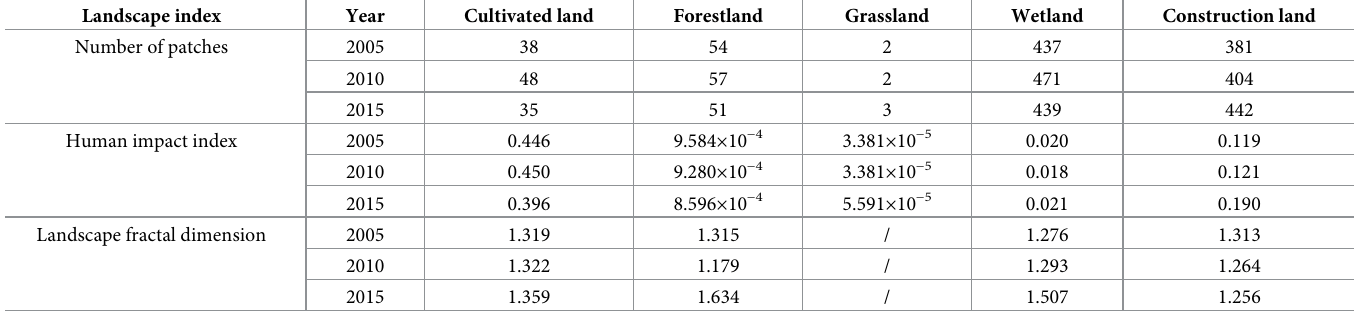
Table 7. Landscape index